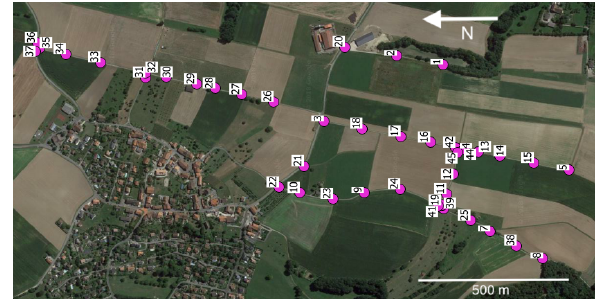
Figure 6. Test side with signalized targets of 30 × 30 cm (Fig. 7)